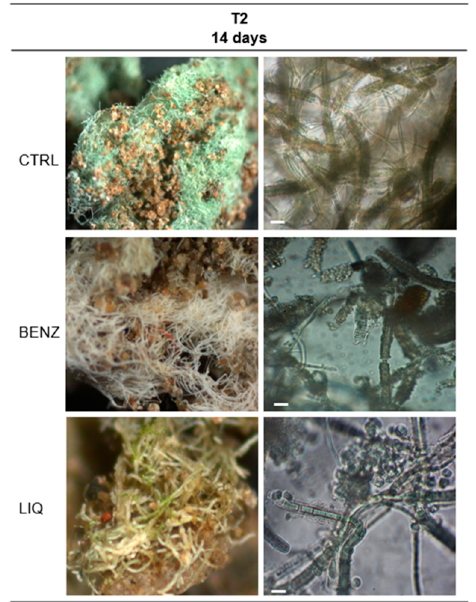
Figure 8. Images at stereo microscope (left column) and light microscope (right column) of in situ biofilms growing in Room 93 after 14 days and two applications of biocides. Bar = 10 μ m.